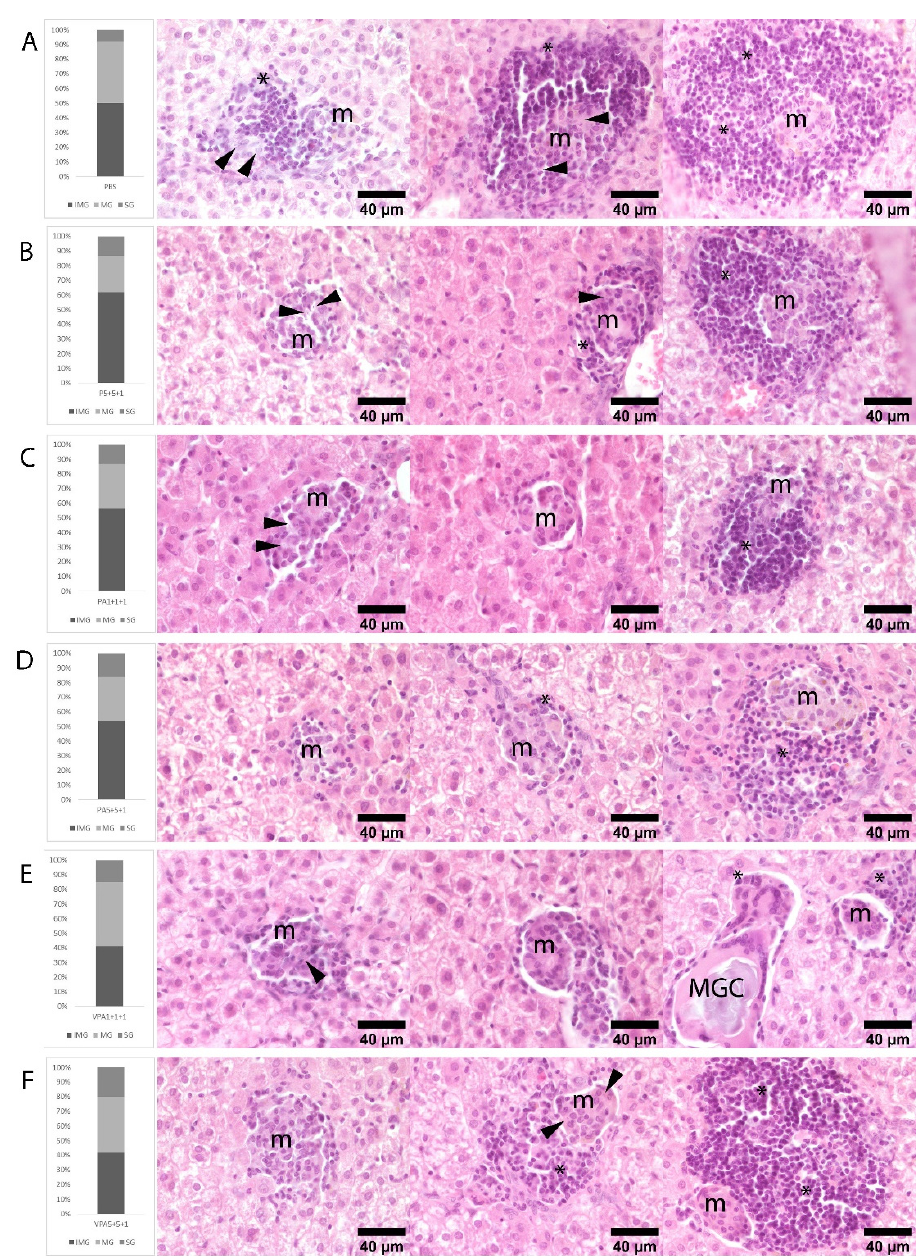
Figure 5. Histological findings in the liver of hamsters infected with L. infantum. Rows illustrate the percentage of immature (IMG), mature (MG), and sterile (SG) granulomas observed in hematoxylin- eosin stained liver sections of hamsters at 12 weeks post-infection: ( A ) PBS, ( B ) P 5 + 5 + 1, ( C ) PA 1 + 1 + 1, ( D ) PA 5 + 5 + 1, ( E ) VPA 1 + 1 + 1, and ( F ) VPA 5 + 5 + 1 groups. Immature granulomas consist of poorly defined aggregates of macrophages (m) and small numbers of intermixed lymphocytes (*). Mature granulomas are more organized and surrounded by small numbers of lymphocytes. Sterile granulomas contain small compact aggregates of macrophages surrounded by moder- ate to large numbers of lymphocytes, all devoid of amastigotes. Amastigotes in immature and ma- ture granulomas are pointed out by arrows. Rare multinucleated giant cells (MGCs) containing membrane rests and mineral debris were seen mainly in SG and lesser in MG. n = 9 animals per group.